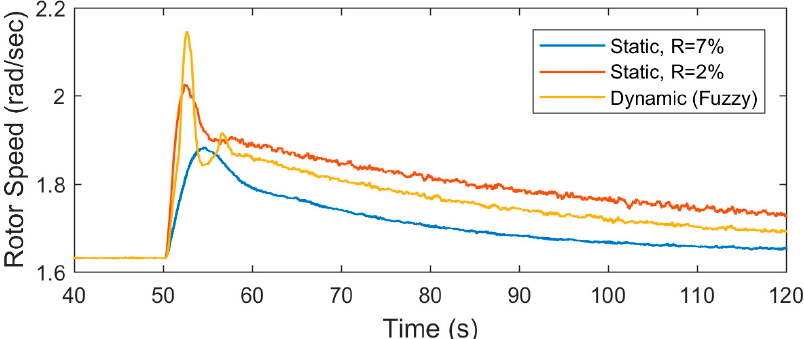
Figure 10. Rotor speed (large ROCOF).